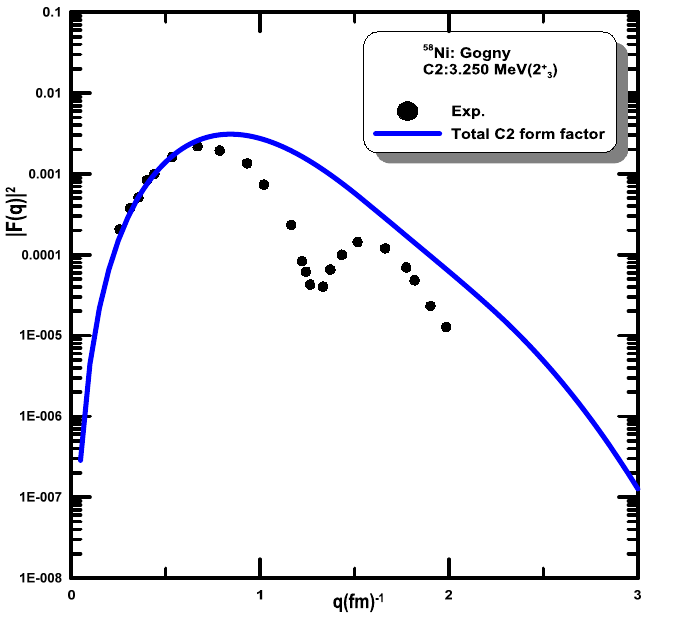
2 state at Ex= 3.250 MeV in 58 Ni 3